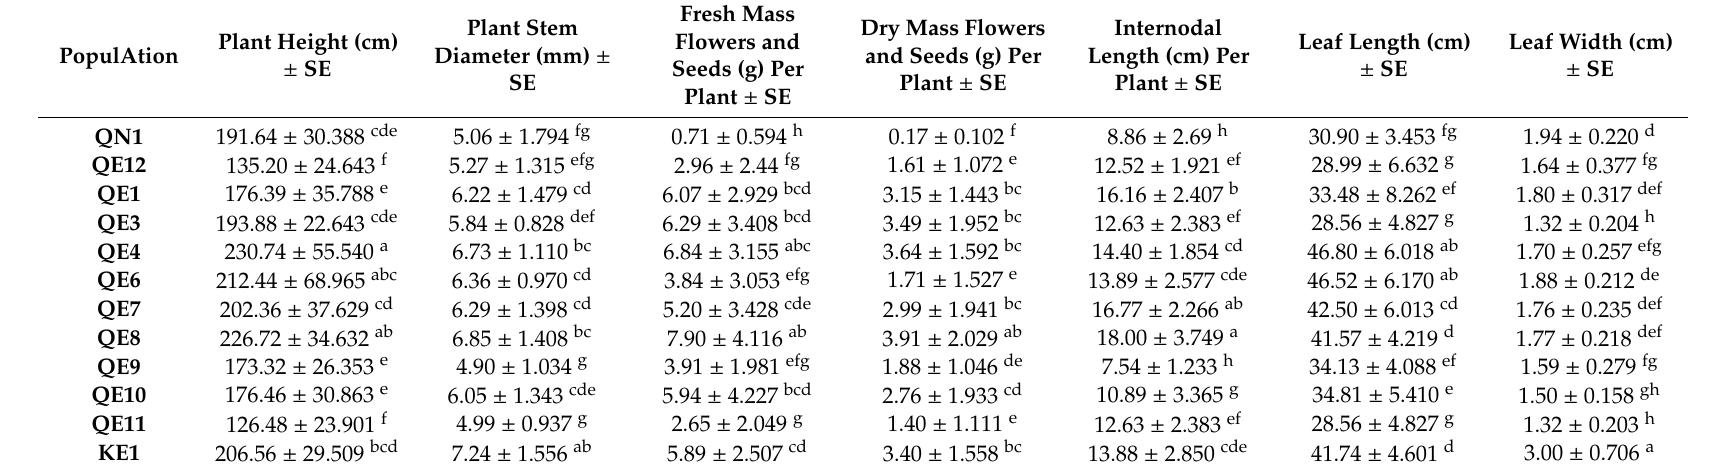
Means that are followed by the same letter in columns are not significantly di ff erent using Duncan’s Multiple Range Test; native population (QN1) in